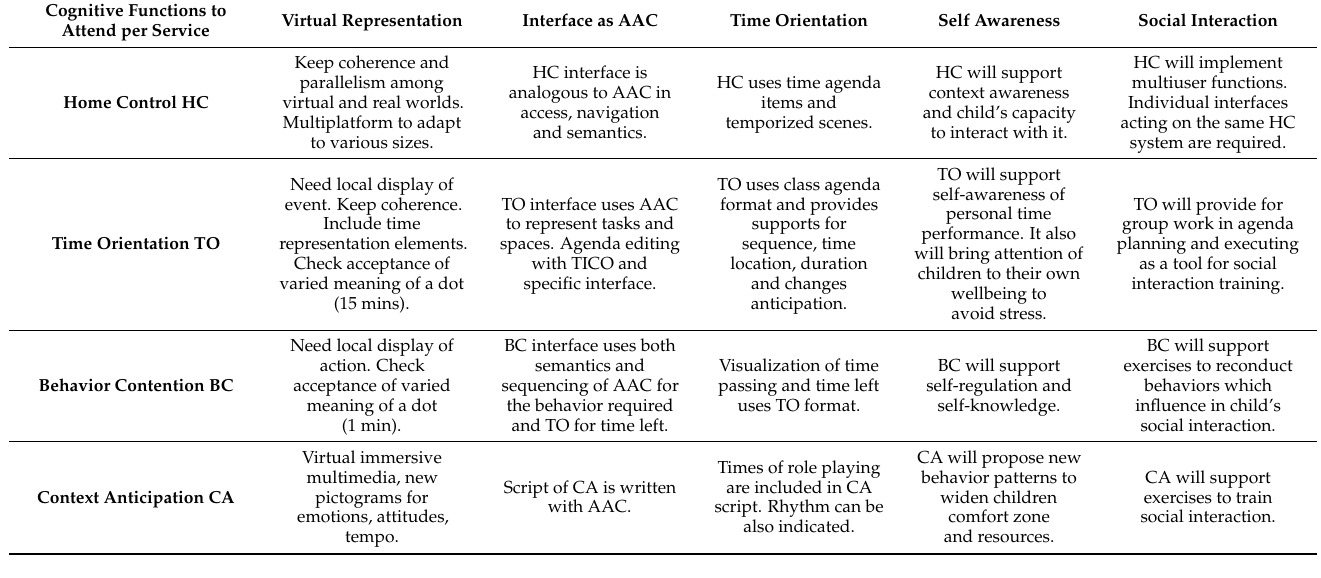
Table 1. Functions to implement per service to attend cognitive items.